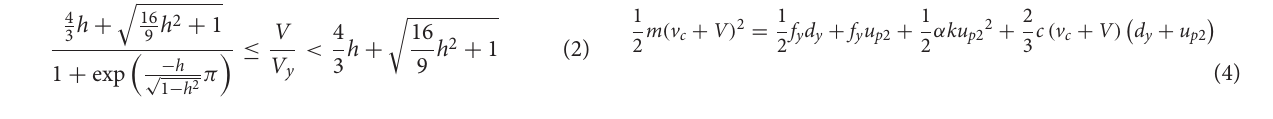
The left-hand side of Equation (3) indicates the kinetic